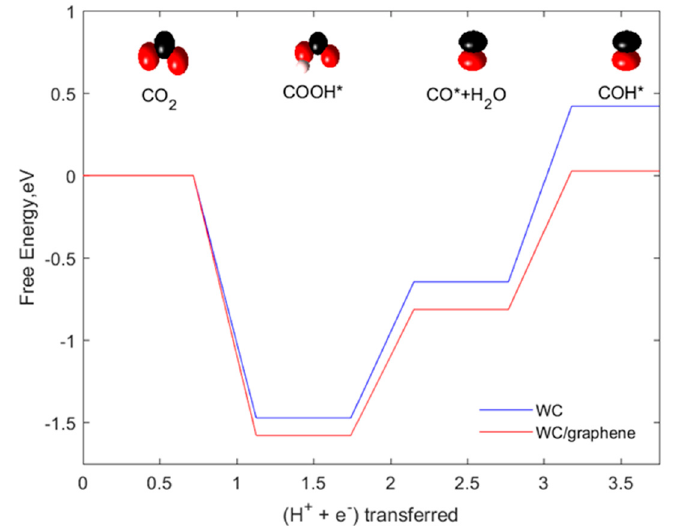
Figure 9. Comparison of reaction energetics of CO 2 reduction on WC nanocluster (blue) and graphene supported WC nanocluster (red). Color code of atoms: red: oxygen, black: carbon, white: hydrogen.